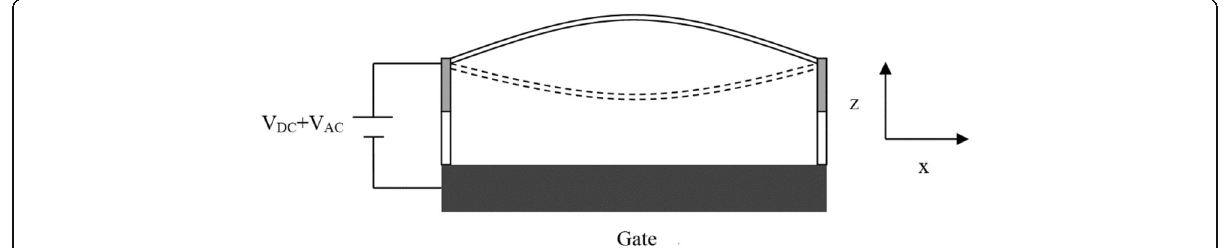
Fig. 1 Schematic figure of the double-clamped silicon nanowire